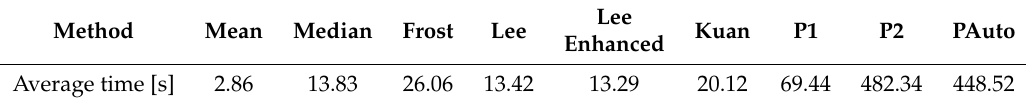
Table 3. Average execution